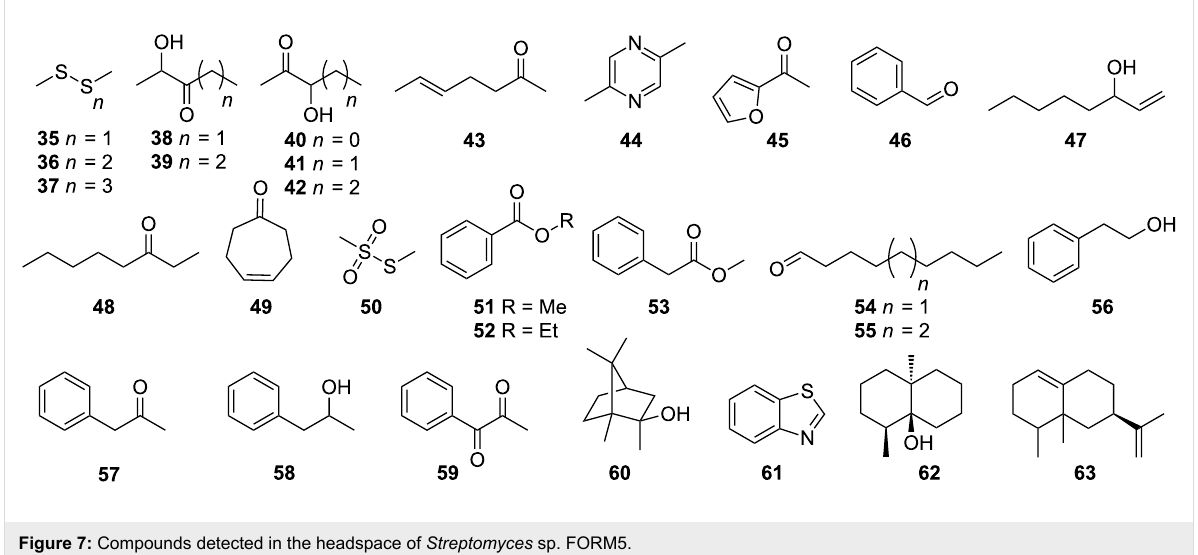
Figure 7: Compounds detected in the headspace of Streptomyces sp. FORM5.